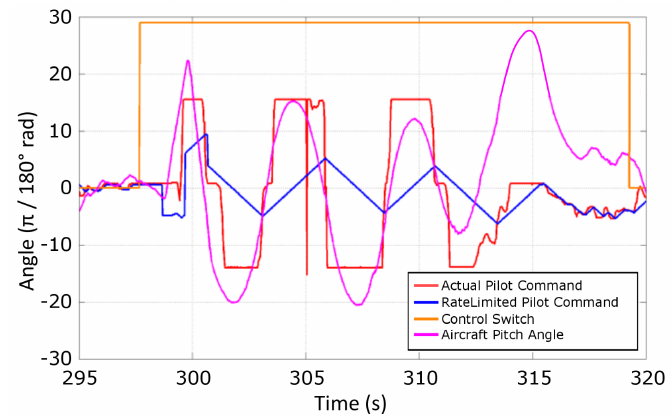
Figure 21. Flight experiments for 8.25 ◦ /s elevator rate